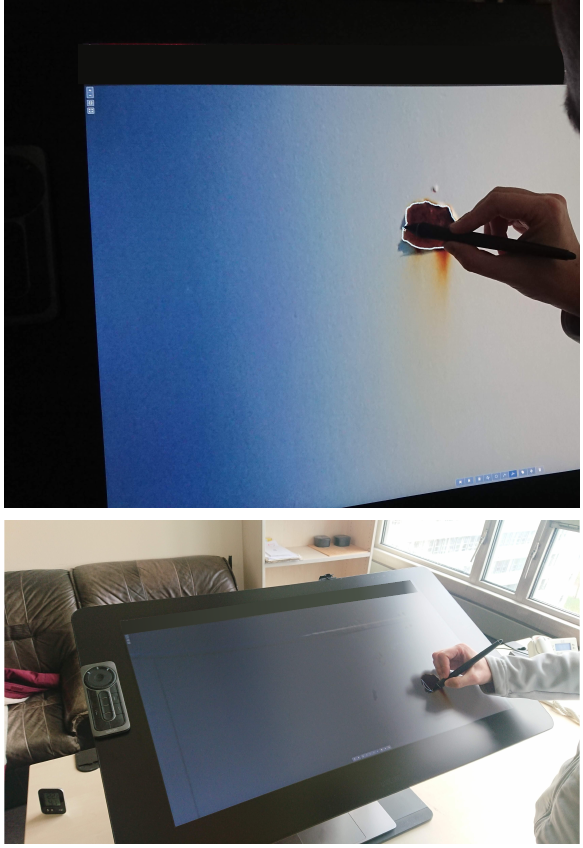
Figure 3. Annotation on wind turbines using BIIGLE